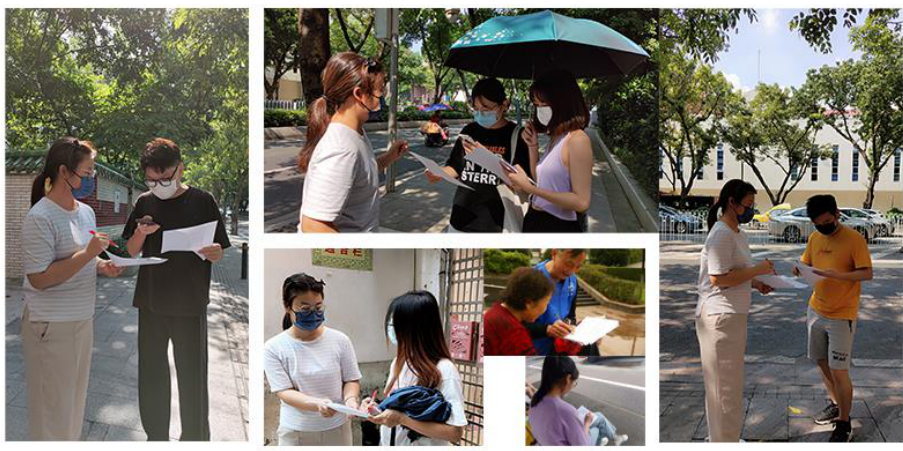
Figure 4. Site map of questionnaire distribution.